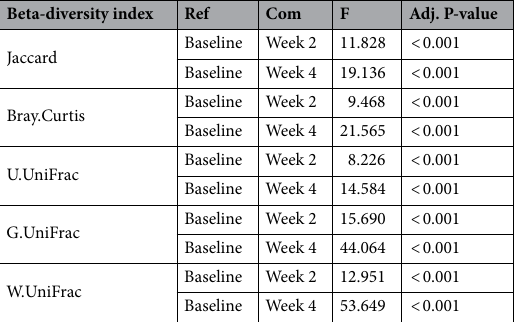
Table 2. The results for comparitive analysis in beta-diversity (pairwise comparisons). *Ref represents the reference/baseline group, Com represents the comparison group, F represents the F statistic value, and Adj. P-value represents the FDR adjusted